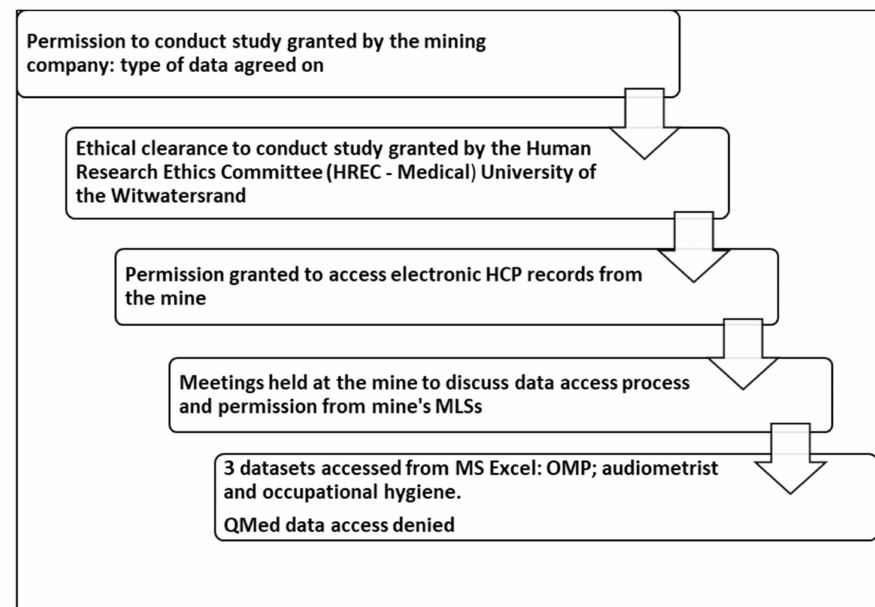
Figure 2. Ethical considerations in the data collection process (Human research ethics committee (HREC); Hearing conservation programme (HCP); Machine learning system (MLS); Occupational medical practitioner